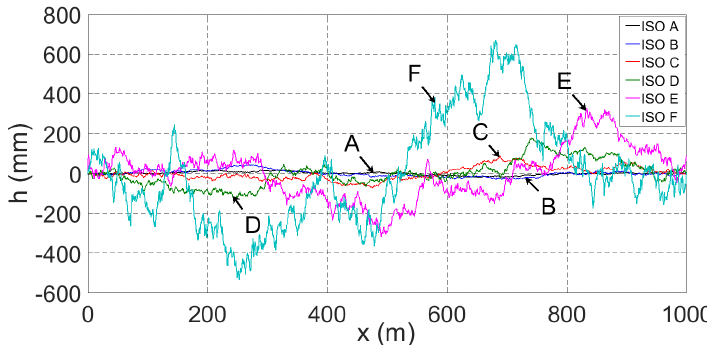
Figure 4. The road profiles according to the ISO standard 8608:2016 (A–F).